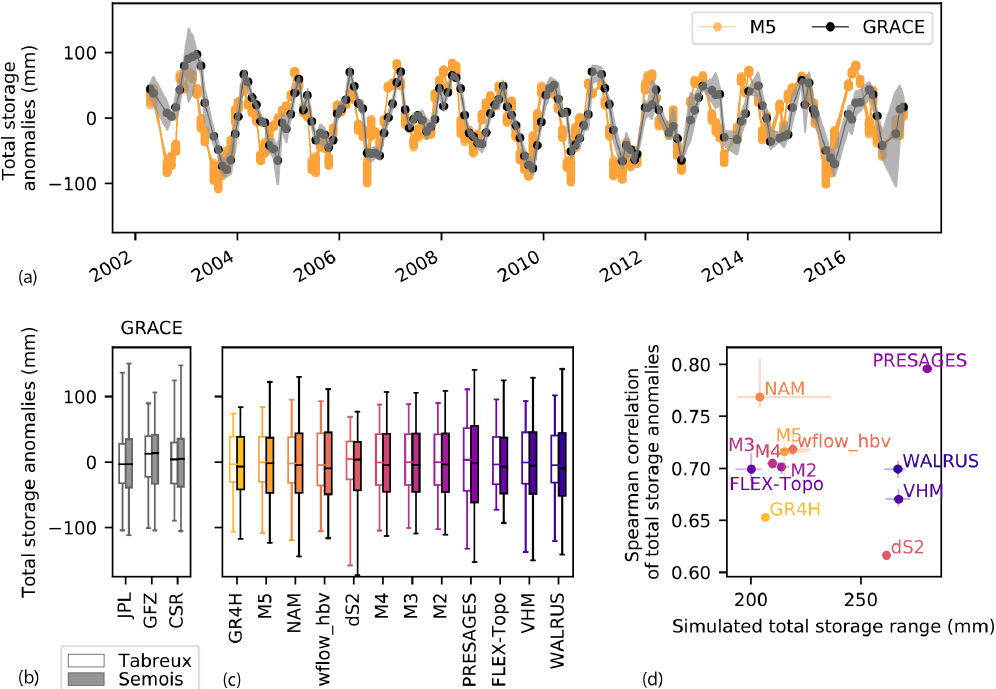
Figure 7. (a) Total storage anomalies modeled by M5 and compared to GRACE for the Ourthe upstream of Tabreux. The grey band shows the variability in total storage anomalies of the three processing centers. (b) Range of GRACE total storage anomalies for the three processing centers for the Semois upstream of Membre-Pont compared to the Ourthe upstream of Tabreux for the period 2001–2017. (c) Modeled total storage anomalies for both catchments. (d) Spearman rank correlations between GRACE and modeled total storage anomalies as a function of the range of modeled total storage for the Ourthe upstream of